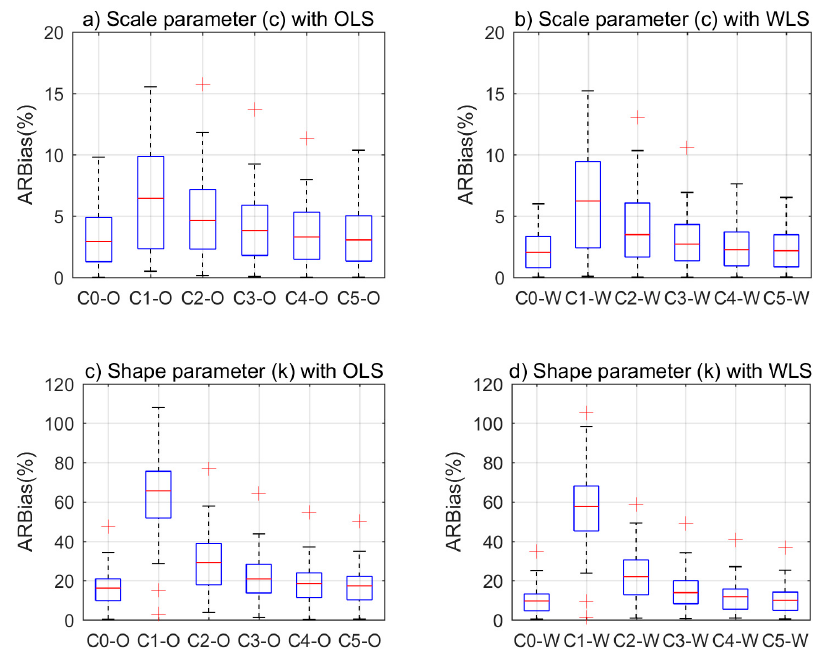
Figure 7. Boxplots of the ARBias (%) of scale (c) and shape (k) parameters of the downscaled Weibull distribution with the OLS and WLS methods based on the parameter estimates from the observed Weibull distribution. Note that ( a – d ) presents boxplots of scale parameter estimates with OLS, scale parameter estiamtes with WLS, shape parameter estimates with OLS, and shape parameter with WLS, respectively.